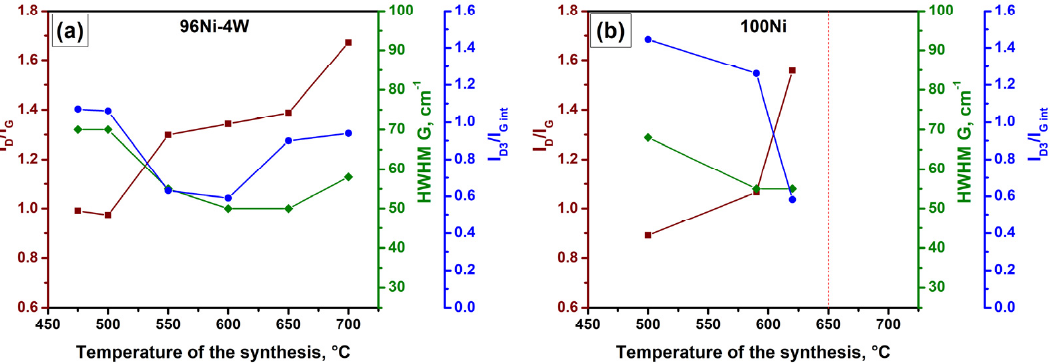
Figure 10. Dependences of the parameters (ID/IG, ID3/IGint, and HWHM G) on the synthesis temperature for the samples 96Ni-4W ( a ) and 100Ni ( b ).